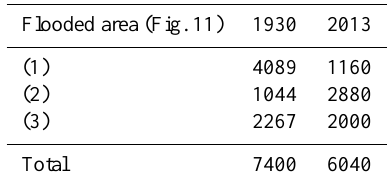
Table 1. Exposed population in 1930 and 2013 for each flooded area (cf. Fig. 11) in